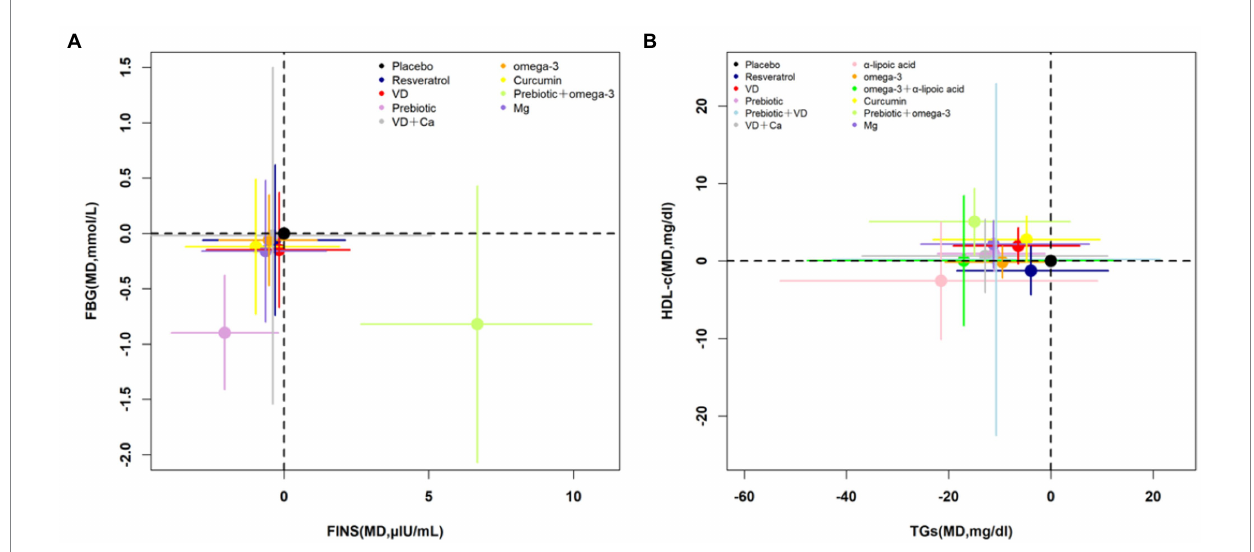
FIGURE 3 Cluster-rank plots. (A) The cluster-rank plot of FBG and FINS. (B) The cluster-rank plot of HDL-C and TGs. (The cluster-rank value is the product of the abscissa and ordinate of each treatment.) FBG, fasting blood glucose; FINS, fasting insulin level; TGs, triglycerides; TC, total cholesterol; HDL-C, high- density lipoprotein cholesterol; VD, vitamin D; Ca, calcium; Mg,